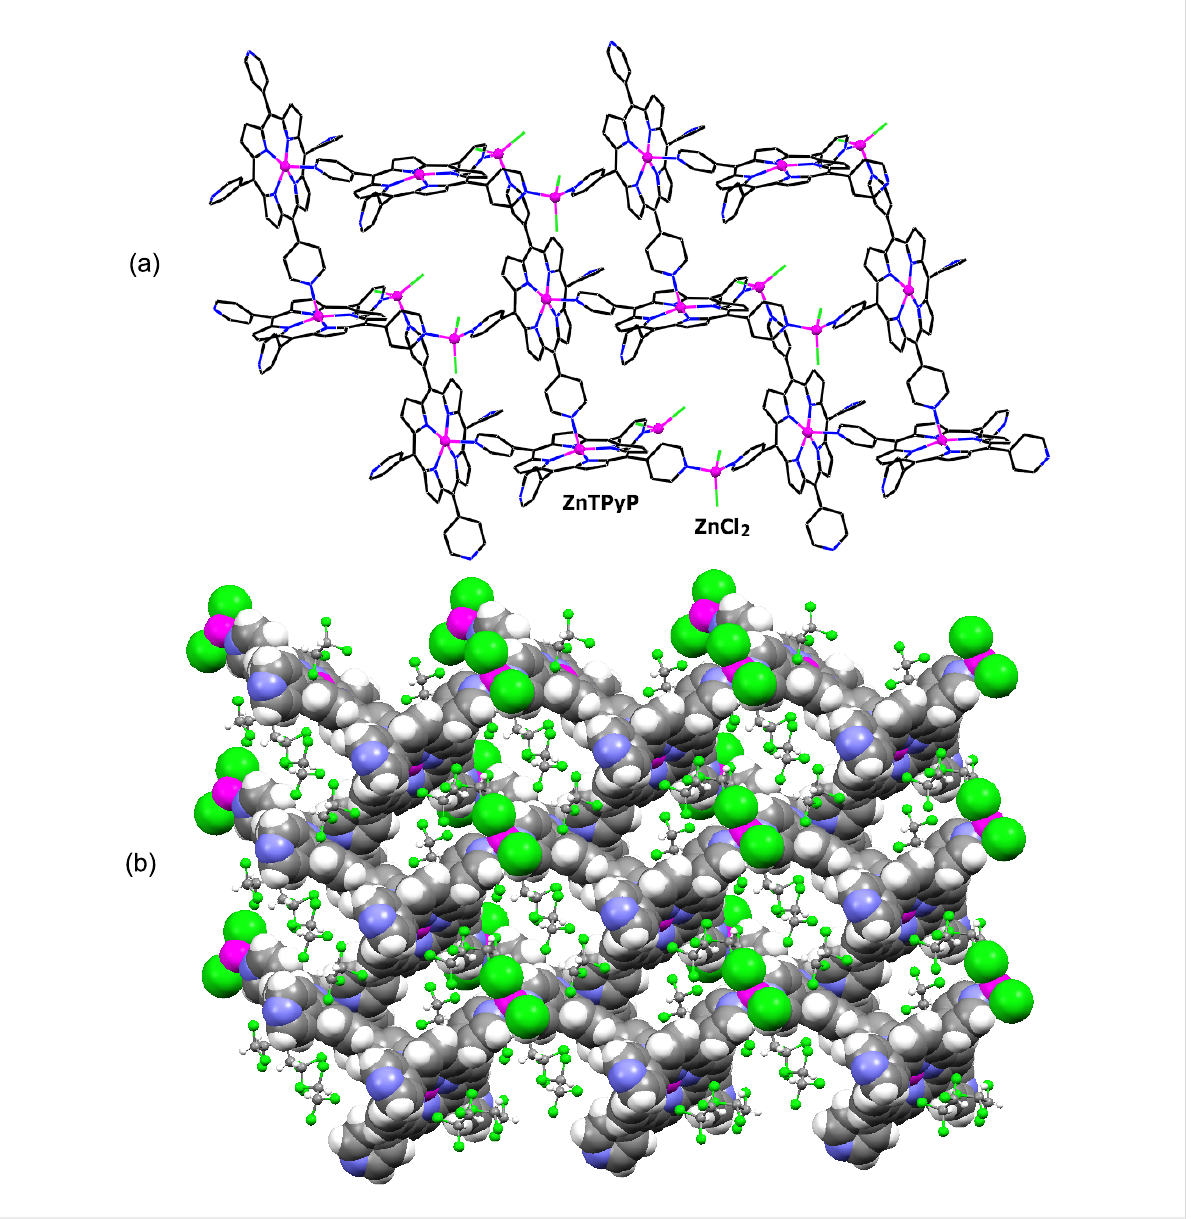
Figure 1: Fragment of the continuous coordination scheme in I , forming a corrugated layer that is aligned perpendicular to the c -axis of the crystal. (a) Wireframe presentation, with the exception of the zinc ions which are depicted as small spheres, illustrating the connectivity scheme. (b) Space-filling view of the coordination polymer. Note that the ZnCl 2 bridges and the non-coordinated pyridyl groups point outward from the network. The interpor- phyrin kinks and voids within the polymeric layer, as well as between neighboring layers, are occupied by the TCE solvent (shown as “ball-and-stick”